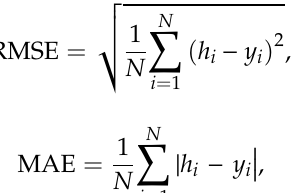
equipment and ( b ) interior view of the equipment.